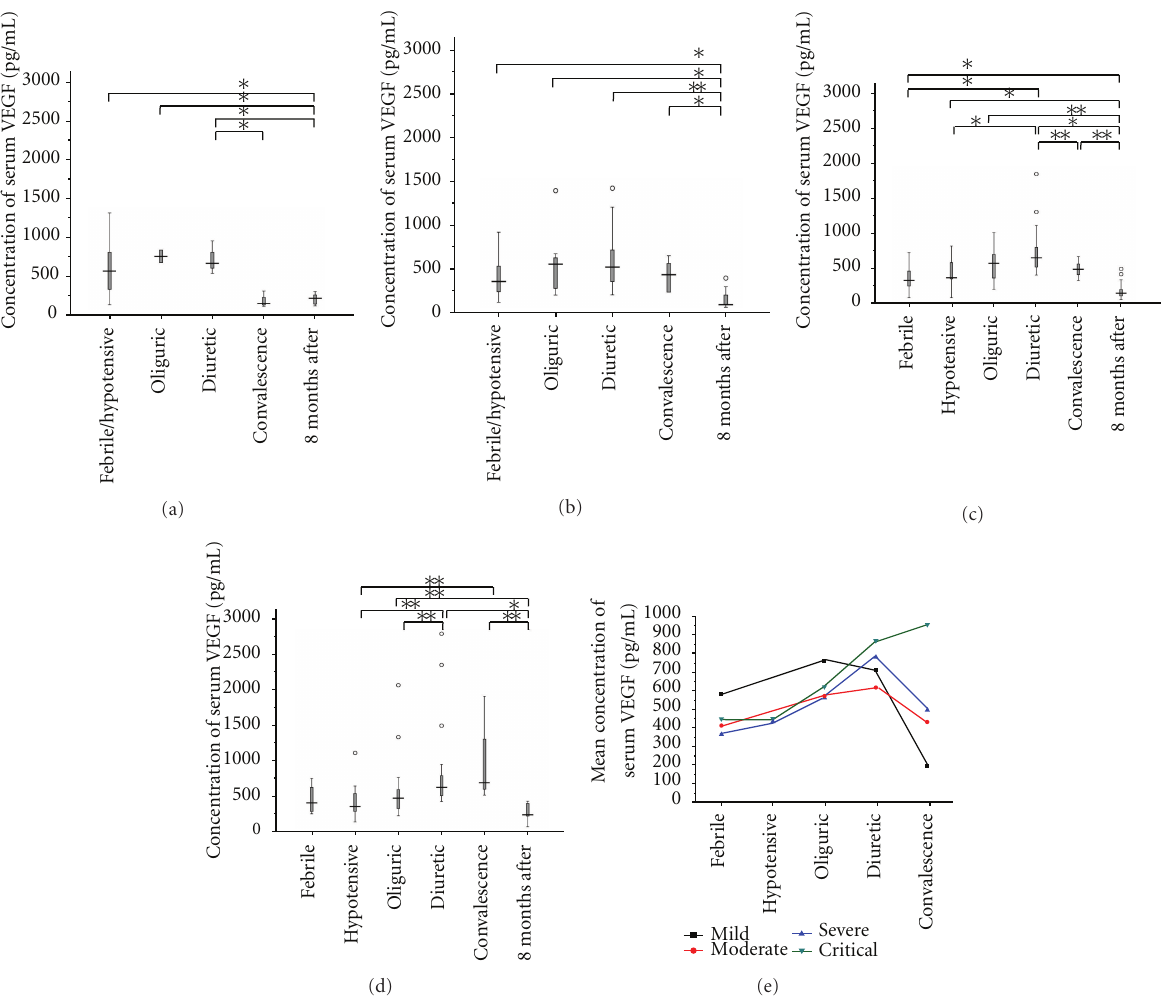
Figure 1: Compare the concentration of serum VEGF among di ff erent stages and 8 months after discharge in each severity group of HFRS patients. (a) Mild patients, (b) moderate patients, (c) severe patients, and (d) critical patients were investigated. The level of serum VEGF in di ff erent severity groups was generally elevated from onset of fever and then gradually elevated. It could recover to the normal level 8 months after discharge irrespective of the severity of the patients. (e) The dynamic changes in the mean level of serum VEGF at each stage of HFRS in four di ff erent severity groups were investigated. Mann-Whitney U -test or Student’s t -test was used for a two-group comparison. ∗ P < 0 . 05, ∗∗ P < 0 .